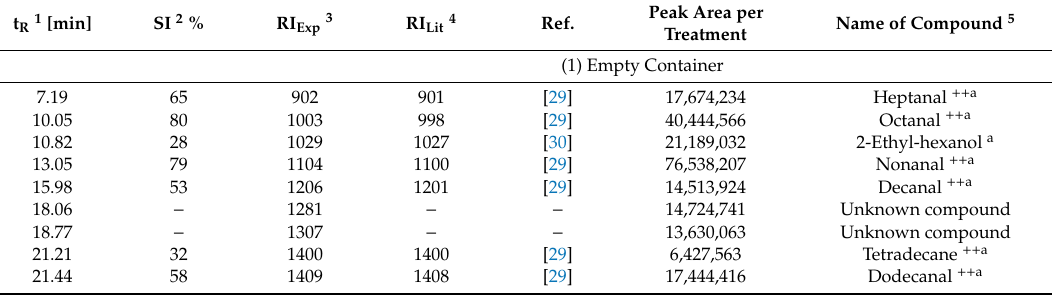
Figure 2. Variability of twelve differential sensor signals assigned to the twelve investigated microorganisms. Vectors were colored according to their contribution to total variance: orange—low, blue—high. Blue dots represent controls: 1—empty flask, and 2—PDA medium; red dots—microorganisms with the most pronounced eigenvalues, black dots—microorganisms with less pronounced eigenvalues (cf. Table S2, Figure S1). Table 1. The VOC emission pattern detected using a SPME-GC / MS method in the headspace atmosphere of samples tested at BUT. Similarity indices (SI) were obtained by comparing a profile of the EI mass spectrum of a given VOC compound with the reference one in NIST Mass Spectral Database library; these values represent the confidence in the molecular